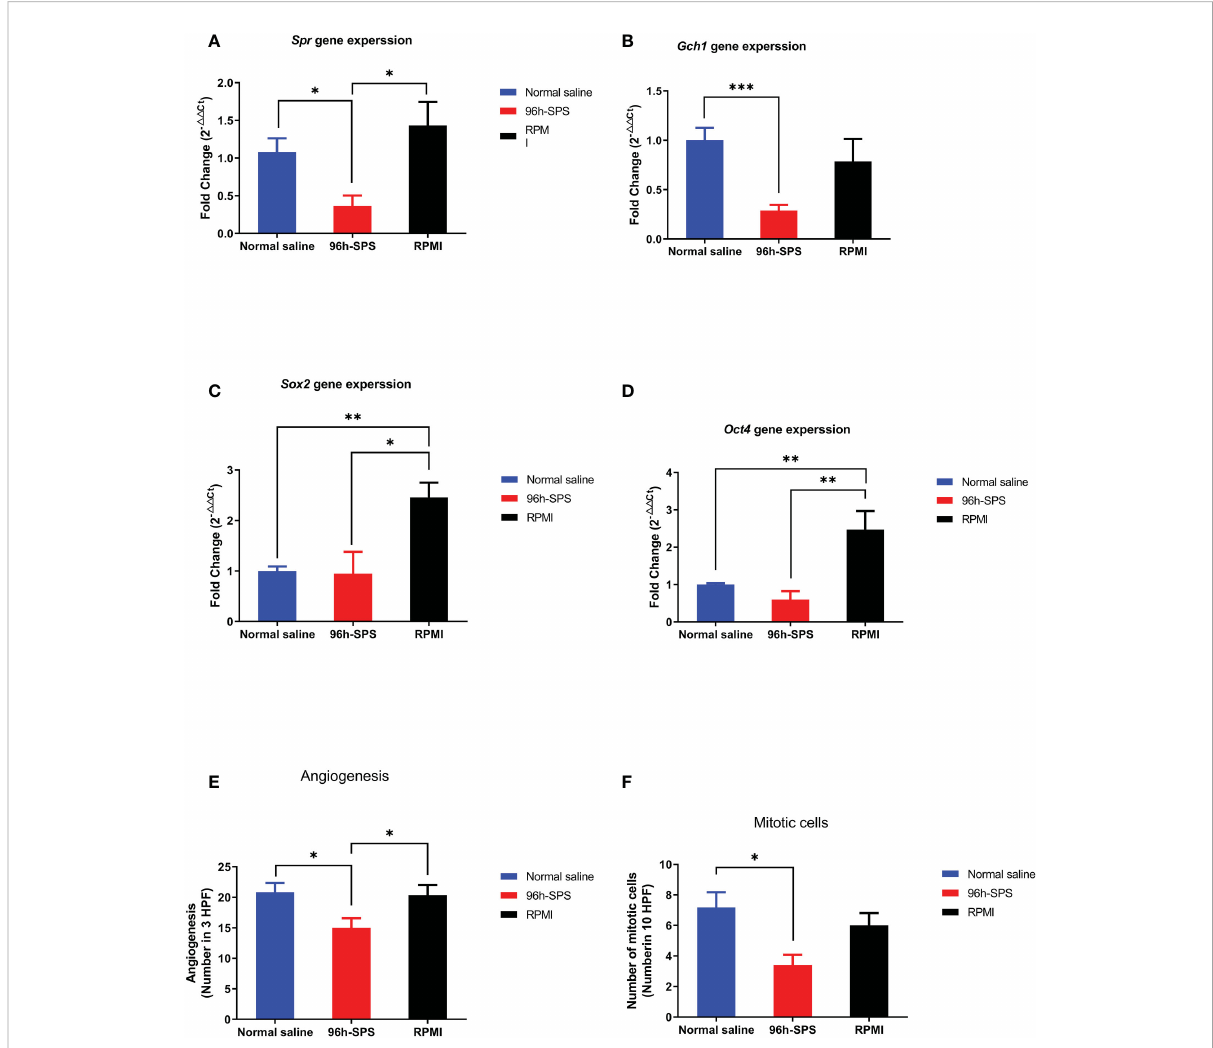
FIGURE 7 (A – D) Gene expression of target genes, that is, Spr , Gch1 , Oct 4, and Sox2 . (E, F) Angiogenesis and mitosis in the tumors from rats exposed to 96 h-SPS, normal saline, and RPMI treatment. (A) Spr gene expression in LA7-induced tumors. In comparison with normal saline and RPMI groups, the 96 h-SPS – treated tumors showed the lowest level of Spr gene expression, p< 0.05 for both. (B) Gch1 gene expression comparison between groups. 96 h-SPS but not RPMI solution was able to downregulate the Gch1 gene expression signi fi cantly when compared with the normal saline treated tumors, p< 0.001 (C) Gene expression of Sox2 in the tumors isolated from rats. RPMI but not 96 h-SPS solution was able to upregulate the Sox2 expression in comparison with normal saline group, p< 0.05. (D) The expression of Oct4 in rats treated with 96 h-SPS, normal saline, and RPMI solutions. RPMI but not 96 h-SPS solution was able to upregulate the Oct-4 expression in comparison with normal saline group, p< 0.01. (E) The angiogenesis in three indicated groups. In comparison with two other control groups, the 96 h-SPS – treated exhibited the lowest level of angiogenesis, p< 0.05 for both. (F) The number of mitotic cells in different studied groups. In 96 h-SPS – treated tumors, but not in the RPMI group, the number of cells in the mitosis phase of the cell cycle was signi fi cantly lower than normal saline control, p< 0.05. Data expressed as mean ± SD, bars indicate the SD. In each panel. * p < 0.05, ** p < 0.01, and *** p <